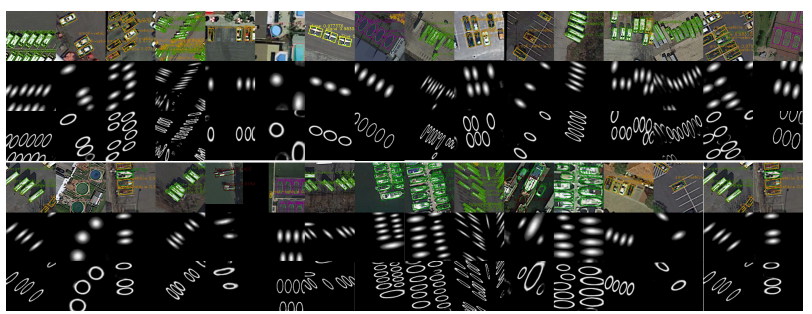
Figure 7. Visualization of detection results in patches of the DOTA testing set. From top to bottom are two groups of detection results, center fields, and edge fields. For the images with multiple categories which correspond to several object fields, we only demonstrate one of them. The green line in the figure represents the elliptic field calculated by ERF. It is surrounded by a circumscribed rectangular box; namely, the oriented bounding box. Rectangular boxes of different colors represent different categories of targets.